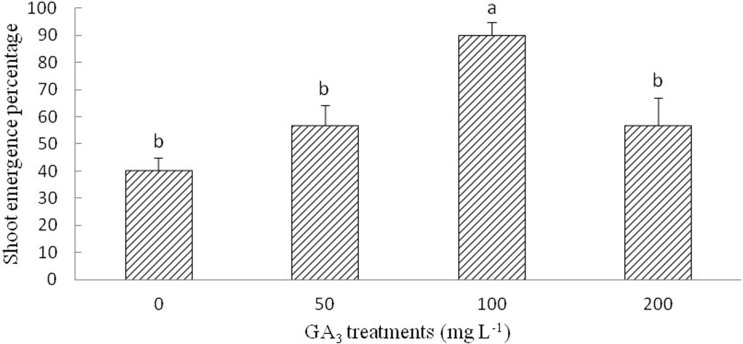
Figure of gibberellic acid (GA3) treatment on shoot growth of Y. longistaminea.Effect of gibberellic acid (GA3) treatment with shoot growth of Y. longistaminea under a 12/12 h photoperiod and 28/20 °C. Values are mean ± standard error (n = 3). Different letters indicate significant differences between the different GA3 solutions (P < 0.05).